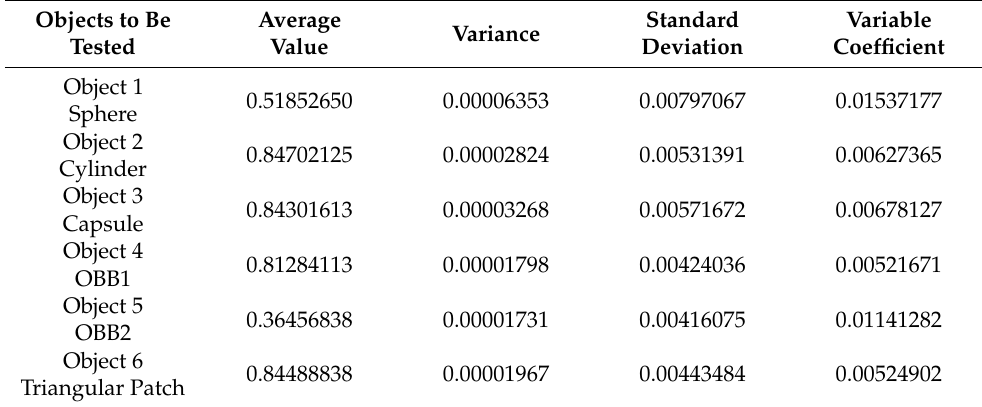
Table A4. Statistical Parameters of the DOR of Each Object Obtained under Different Division Values. Objects to